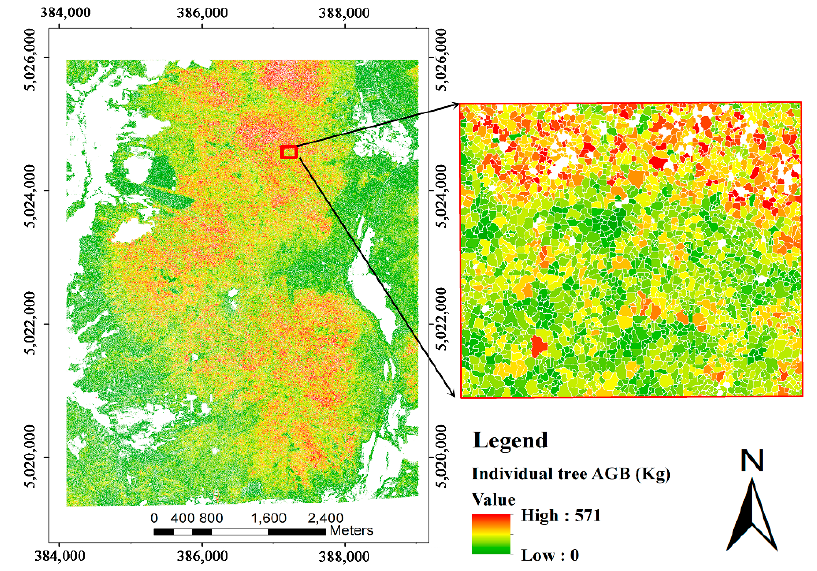
Figure 9. Distribution map of individual tree AGB in the study area.